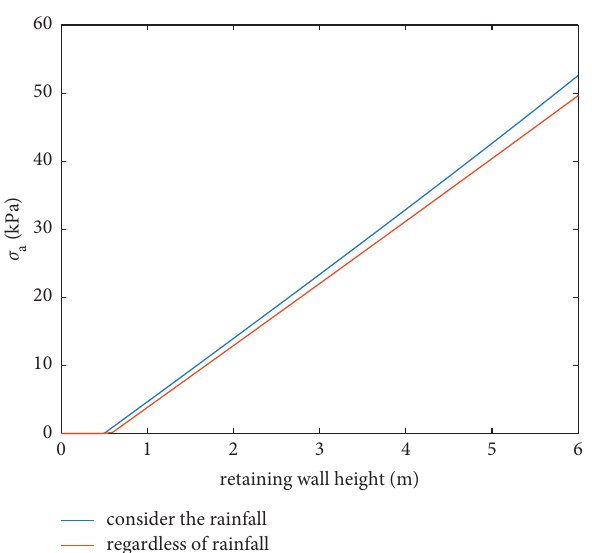
Figure 4: σ a variation with retaining wall height H.